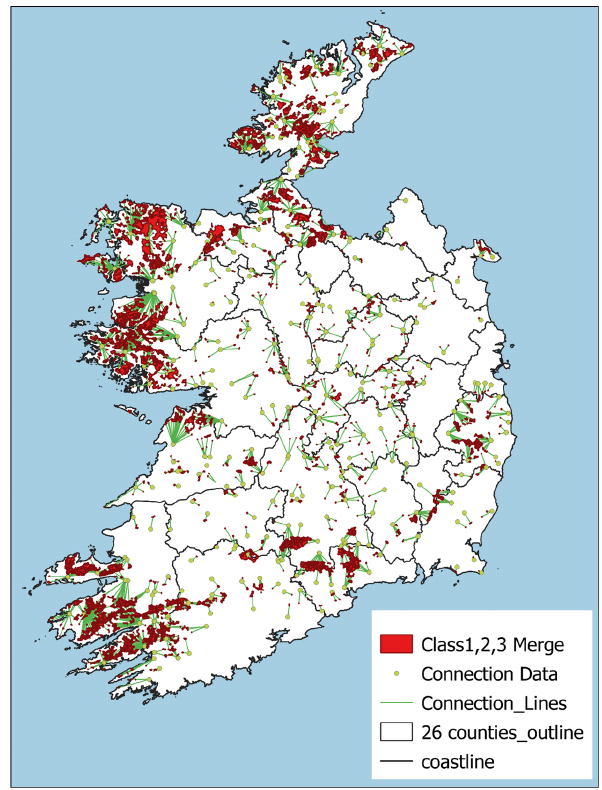
Figure 3. Wind energy potential